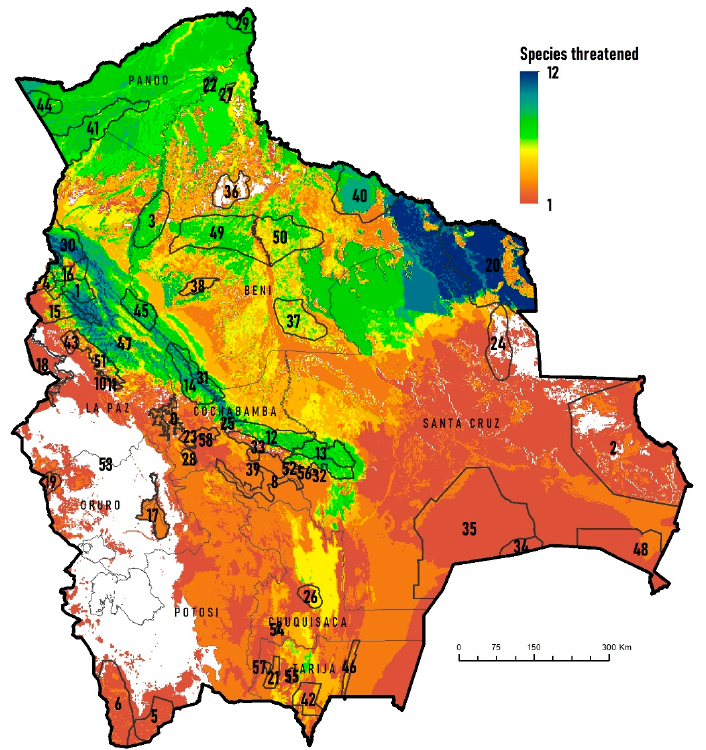
Figure 4. Threatened bird species (Critically Endangered, Endangered, Vulnerable) in relation to Bolivia’s KBAs.